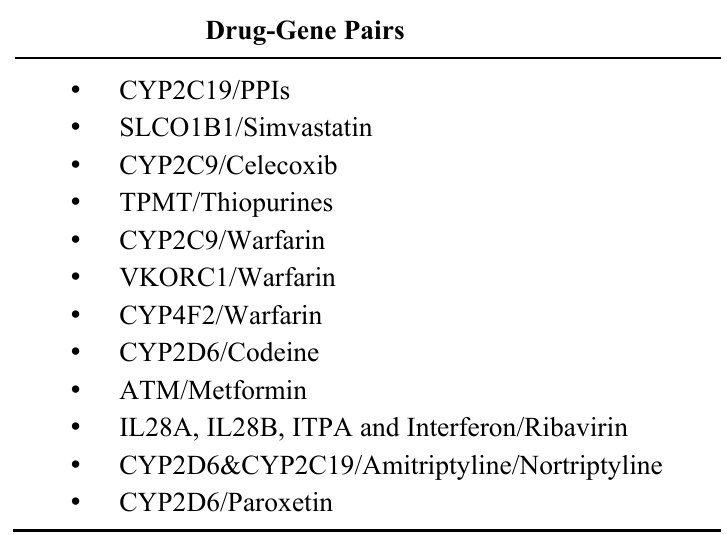
Table 3. Additional CPMC ® approved drug-gene pairs for prospective release.